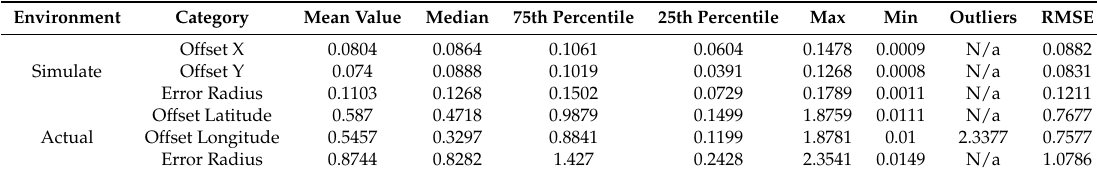
Table 2. Box chart data in the simulation and actual environment.